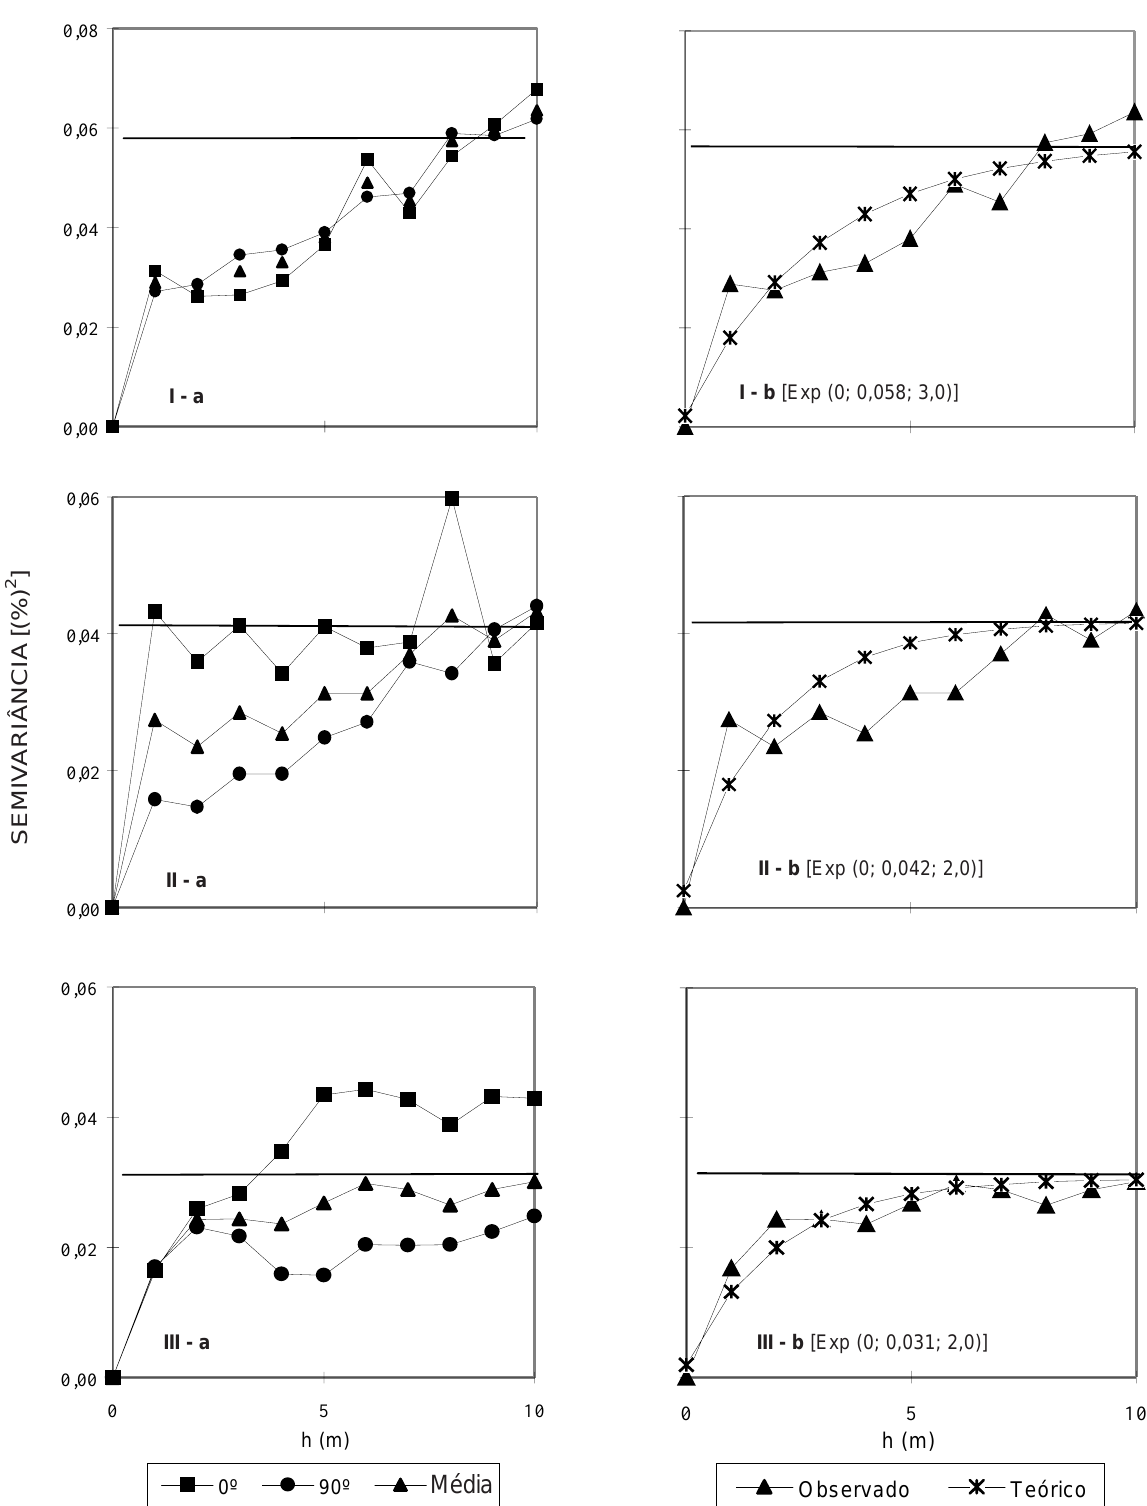
Figura 1. Semivariogramas direcionais e semivariograma médio para o conteúdo de matéria orgânica nos sistemas de cultivo cevada/cevada (Rotação I); ervilhaca-aveia/girassol (Rotação II), e pastagem/ ervilhaca-aveia (Rotação III), Madri, 1993. a) Semivariogramas a 0º e 90º e direção média nos sistemas de cultivo I, II e III. b) Semivariogramas (observado e teórico) na direção média nos sistemas de cultivo I, II e